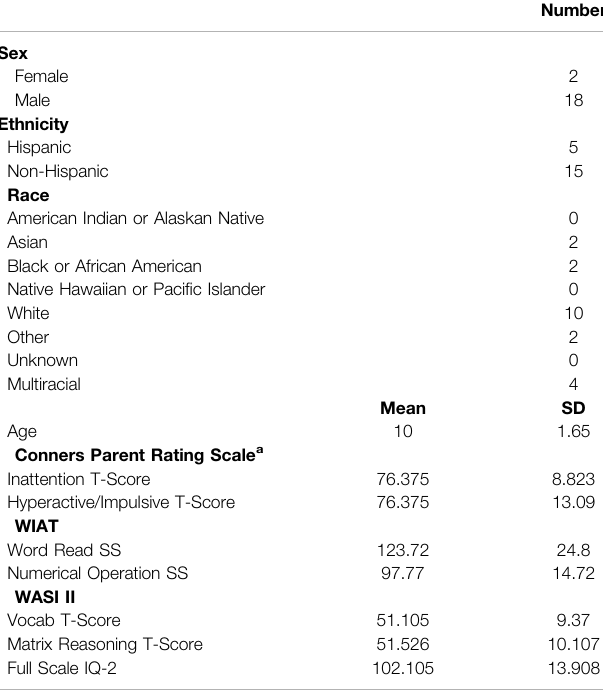
TABLE 1 | Demographic and clinical characteristics of